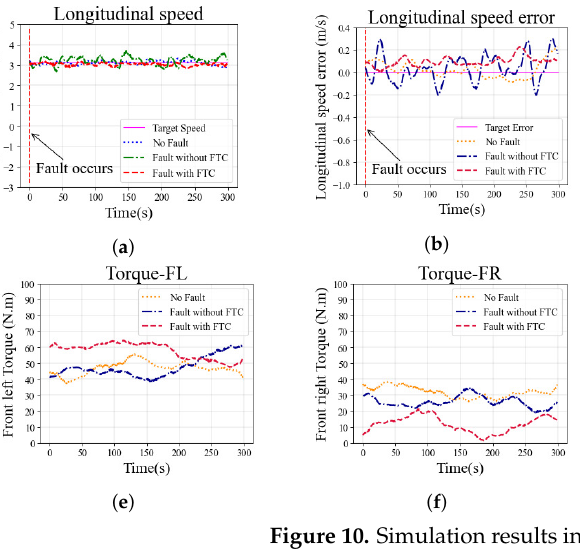
on the rear right wheel: 2